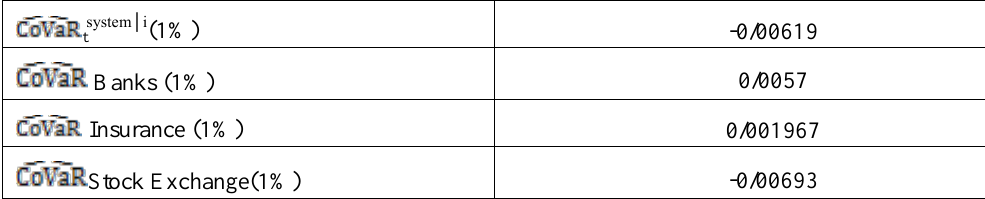
Table 4. CoVaR System, Bank, Insurance and Exchange (with 1%